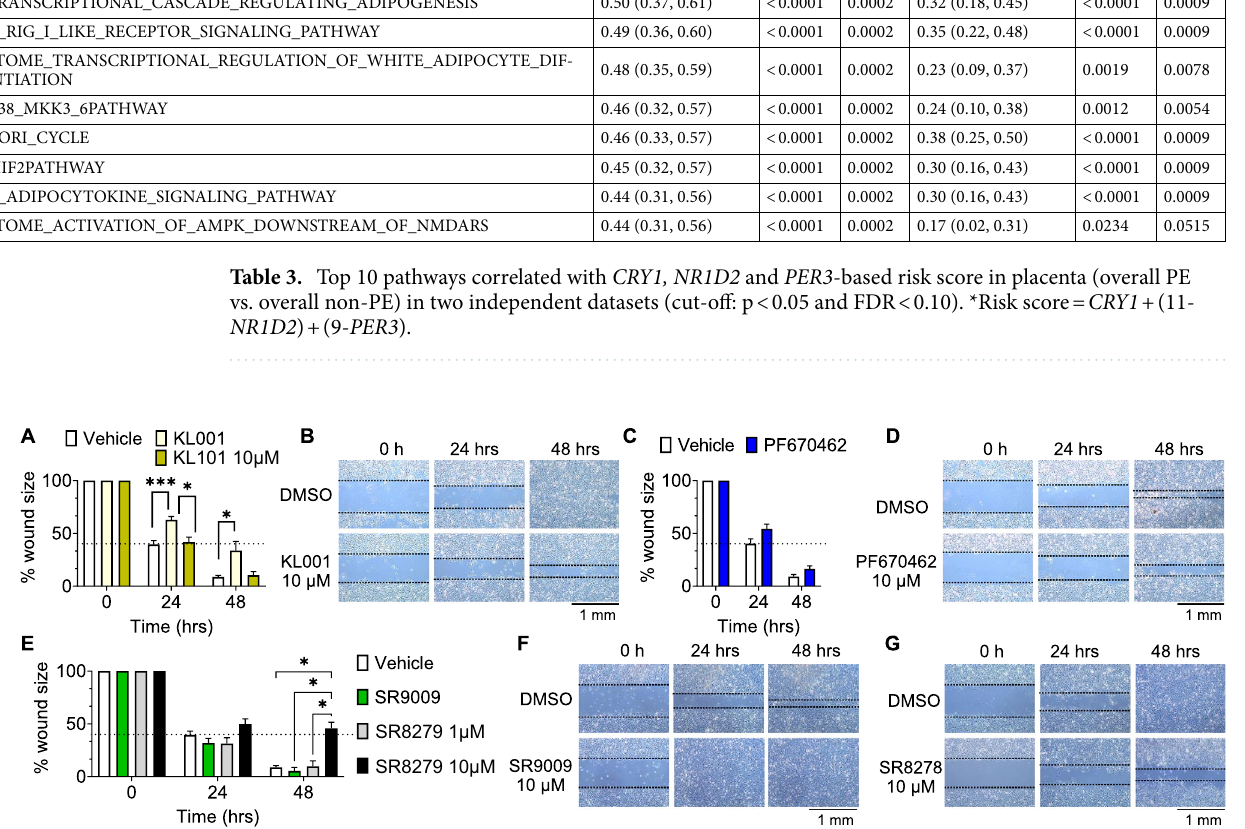
Figure 2. HTR-8 cell migration is regulated by ligands targeting CRY1/2 and NR1D1/2. Wound healing assays in HTR-8 cells, show that ( A , B ) KL001, a drug stabilizing CRY1/2, but not KL101, a drug stabilizing CRY1, reduced HTR-8 cell migration. ( C , D ) PF670462, a drug preventing PER1/2/3 degradation, did not impact HTR-8 cell migration. ( E – G ) The NR1D1/2 agonist SR9009, had no significant effect on migration, whereas the NR1D1/2 antagonist/inverse agonist, SR8278, decreased HTR-8 cell migration. All drugs were tested at 1 and 10 µM. The data were pooled if the two doses were not significantly different. ( B , D , F , G ) Illustrative wound healing assay images. Dotted line on histograms represents approximate wound area in control at 24 h. Data is expressed as % change in average wound size from 0 h ± SEM. N = 3–6, in duplicate. One-way ANOVA repeated measures, *, p < 0.05; ***, p < NR1D2 regulate cell migration, we used the human-derived migratory trophoblast cell line HTR-8 to test drugs targeting CRY1, CRY1/2, PER1/2/3 and NR1D1/2. No drugs specifically targeting PER3 or NR1D2 are cur- rently commercially available, thus only drugs targeting PER1/2/3 and NR1D1/2 were used for the study. Sta- bilizing/upregulating CRY1/2, using KL001 slowed HTR-8 migration at 24 h (Fig. 2A,B), whereas stabilizing/ upregulating CRY1 with KL101, did not impact HTR-8 migration (Fig. 2A); these results suggest that CRY2 or